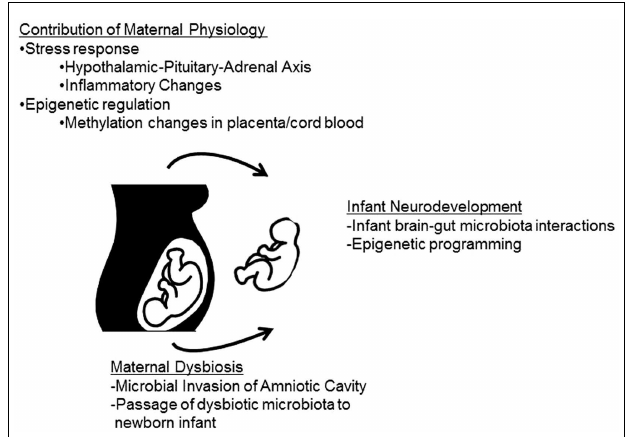
FIGURE 2 | Maternal stress can impact infant neurodevelopment through both microbiota-dependent and -independent pathways .The maternal physiological stress response can directly impact fetal development and may be involved with epigenetic changes in the offspring. In addition, the maternal physiological stress response may impact the commensal microbiota. Infants may become colonized with altered maternal microbes either in utero , through bacterial invasion of the amniotic cavity, or during/after birth when maternal microbes are passed to the infant. Either alterations in infant physiology (including epigenetic modifications) or colonization with dysbiotic microbial communities may lead to deficiencies in infant